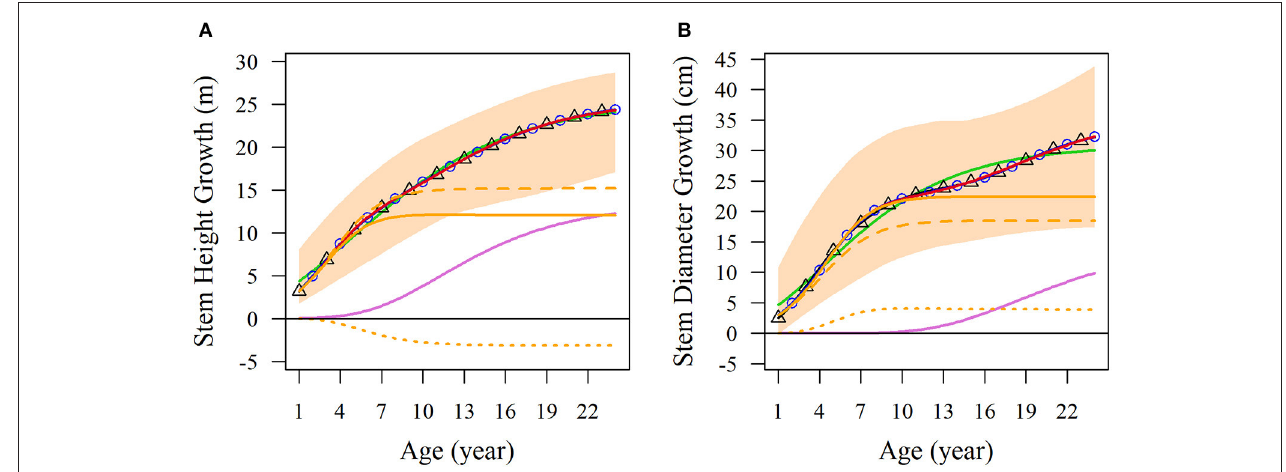
FIGURE 1 | Average growth trajectories of Populus growth. Observed phenotypic ranges of (A) stem height and (B) stem diameter of all the samples are indicated by light orange shading. Average curves of the two traits are fitted with the monophasic equation (green lines), diphasic equation (black lines with triangles), triphasic equation (blue lines with circles), and NGE (red lines). NGE growth curves are divided into the first phase of orange curves and the second phase of light purple curves. In the first phase, the curves are divided into broken lines to represent independent growth, and dotted lines to represent the interaction growth of the two characters. TABLE 1 | Estimated parameters of fitting and evaluation information. Monophasic Diphasic Triphasic Diphasic